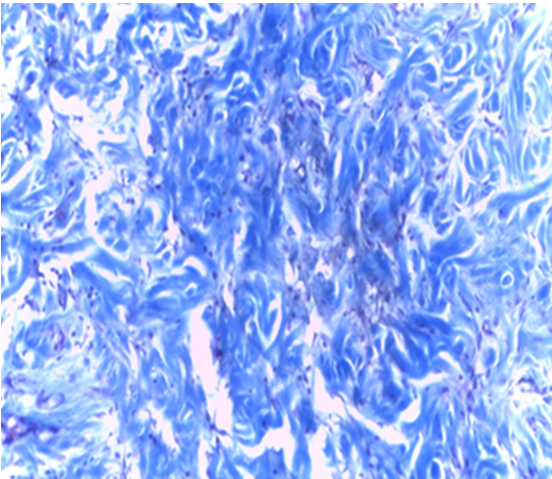
Figure 12. Group B. Dense subcutaneous tissue over the implant with MTA after 30 days. Rare inflammatory cells. Col. Trichrome Masson, ×400 .